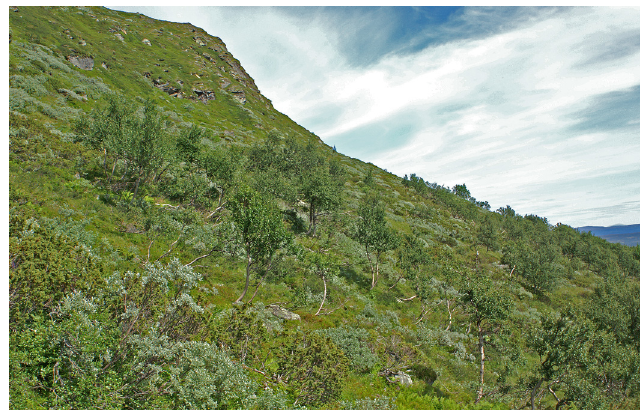
Figure 5: Concave slope morphology offers optimal condi- tions for treeline rise in near-equilibrium with regional evoluti- on of the thermal climate. This landscape was entirely treeless in the early-20th century. Subsequently, the treeline has shif- ted 130 m upslope. Mt. Lillskarven, 1020 m a.s.l. 16 July